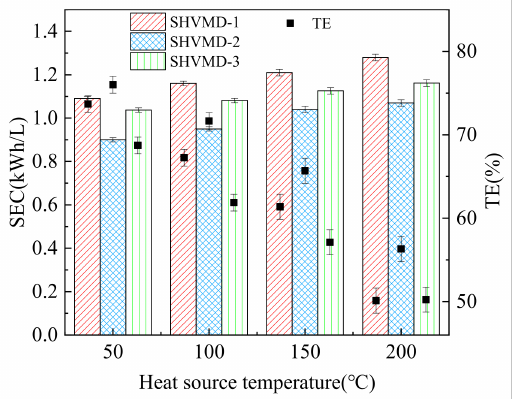
Figure 5. SEC and TE of the three systems under different heat source temperatures. All tests were performed with a feed salinity of 35 g/L, crossflow velocity of 3 cm/s, and vacuum level of 90